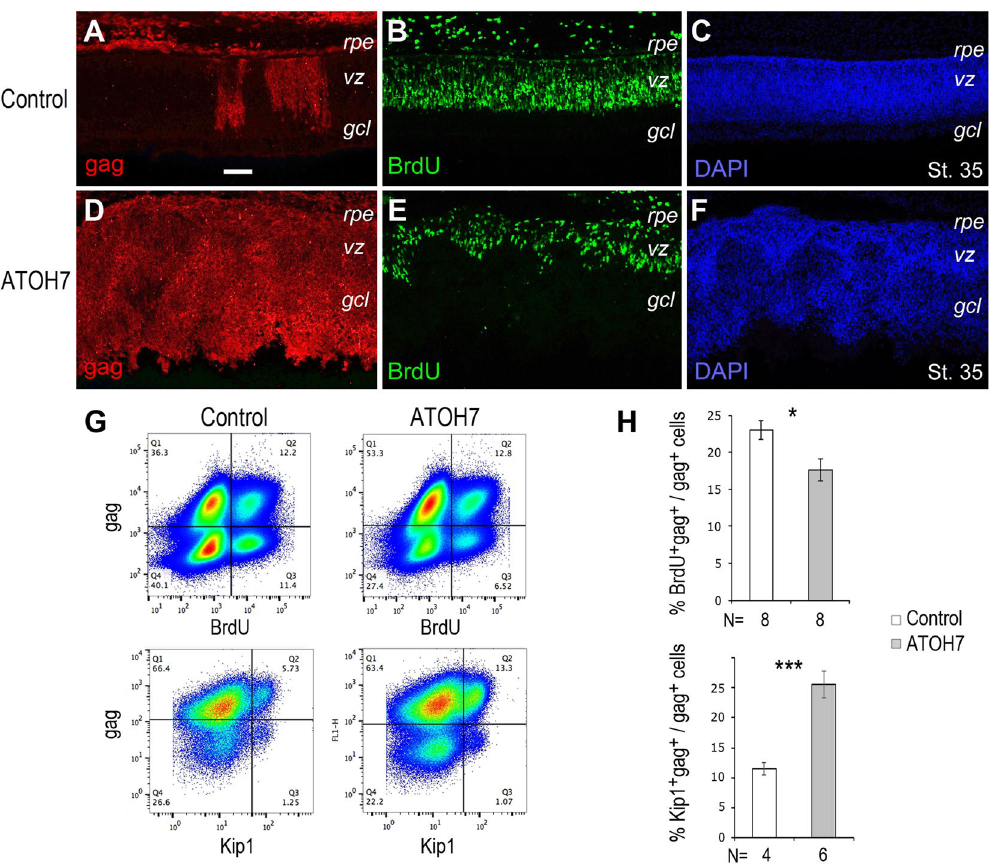
Figure 5. Effect of ATOH7 expression on cell proliferation. ( A – F ) Immunolabeled stage 35 retinal sections infected at stage 17 with the control virus ( A–C , same section) or ATOH7 virus ( D–F , same section). Retinas were labeled for BrdU in vivo for 30 minutes before fixation and analyses. Scale bar: A (for A–F ), 20 μ m. gcl , ganglion cell layer; rpe , retinal pigment epithelium; vz , ventricular zone. ( G , H ) Quantification of BrdU incorporation and p27kip1 expression. ( G ) Representative flow cytometry profiles of stage 30 retinas infected with the control virus and ATOH7 virus at stage 17. ( H ) Bar graphs show percentages of marker positive cells among gag-positive viral infected cells at stage 30. Numbers of independent samples analyzed are indicated below the bars. Error bars indicate SEM. * p < 0.05, *** p <